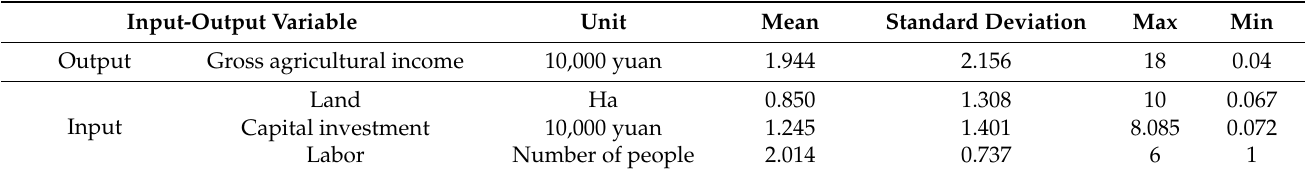
Table 3. Descriptive statistics of input–output